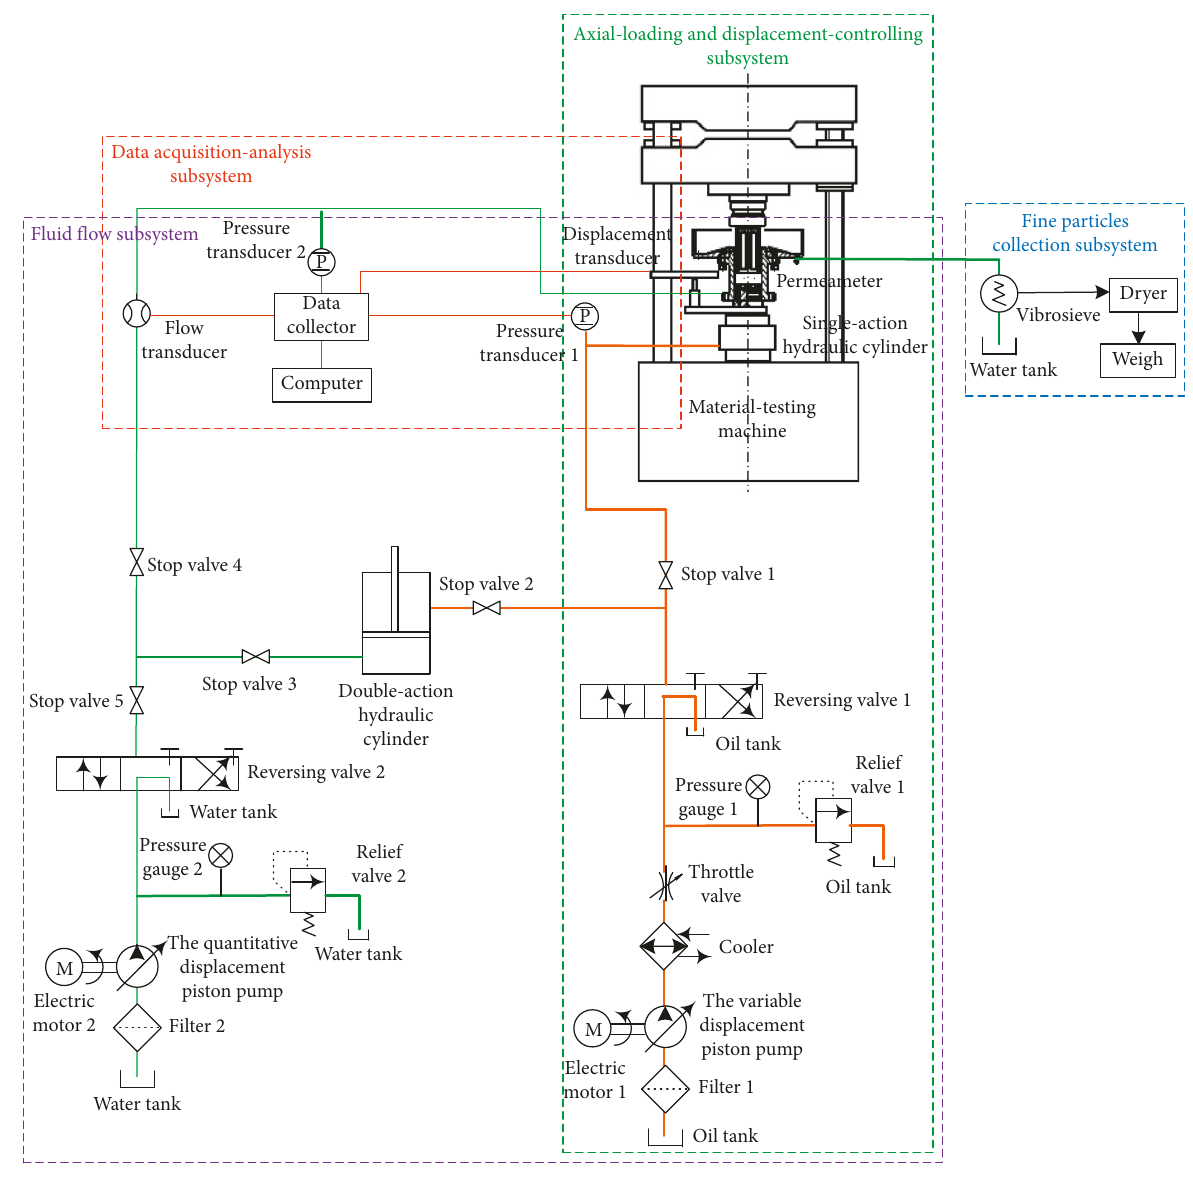
Figure 1: The design of the experimental